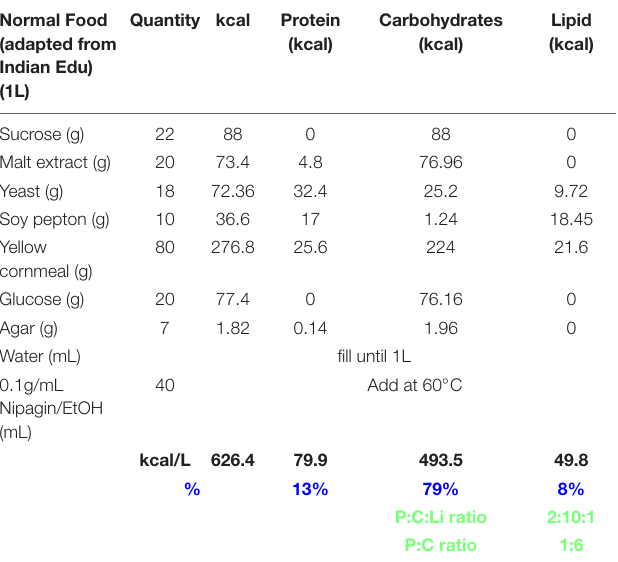
TABLE 3 | Normal food